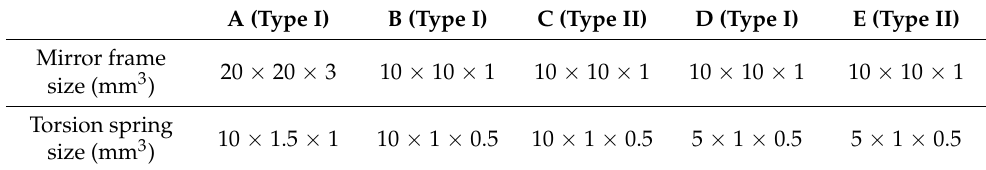
Table 2. Specifications of the designed